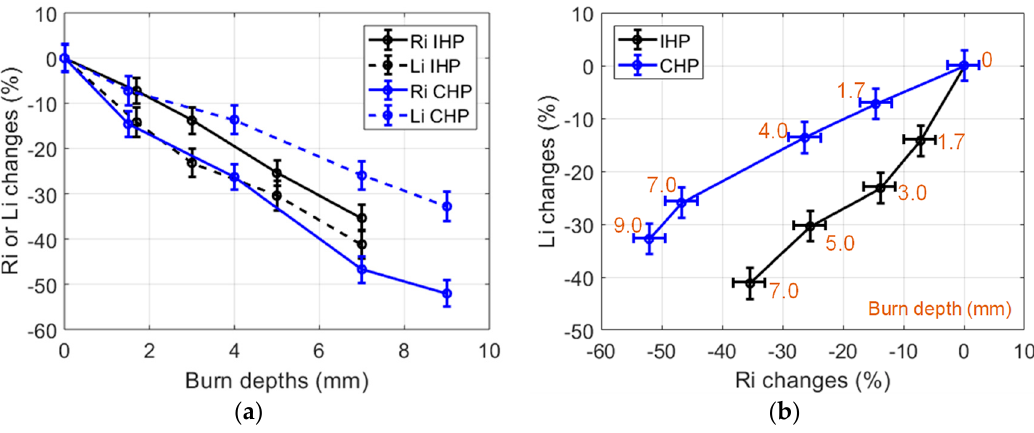
Figure 9 . ( a ) Changes of the dielectric properties of 150 °C IHP-samples and CHP-samples expressed Figure 9. ( a ) Changes of the dielectric properties of 150 ◦ C IHP-samples and CHP-samples expressed in